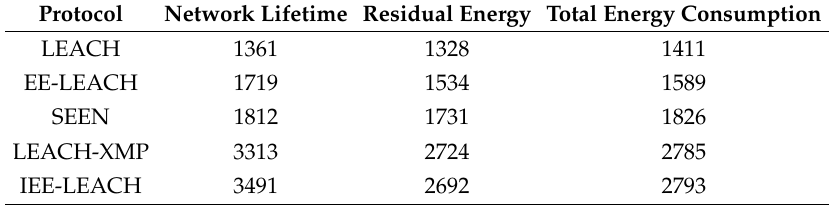
Table 4. A performance comparison between different protocols in a 500 m × 500 m sensor